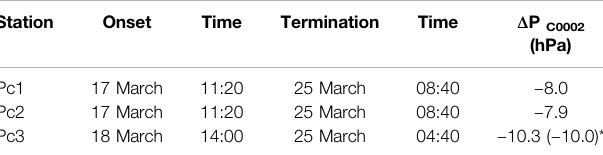
TABLE 3 | Estimation results of pore pressure change due to the SSE in 2020. Station